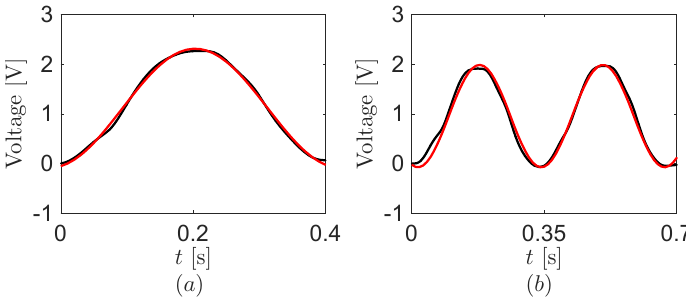
Figure 9. Open-circuit voltage output from the energy harvester. ( a ) One click and ( b ) double click. Black and red lines are the experimental data and its fundamental harmonics,